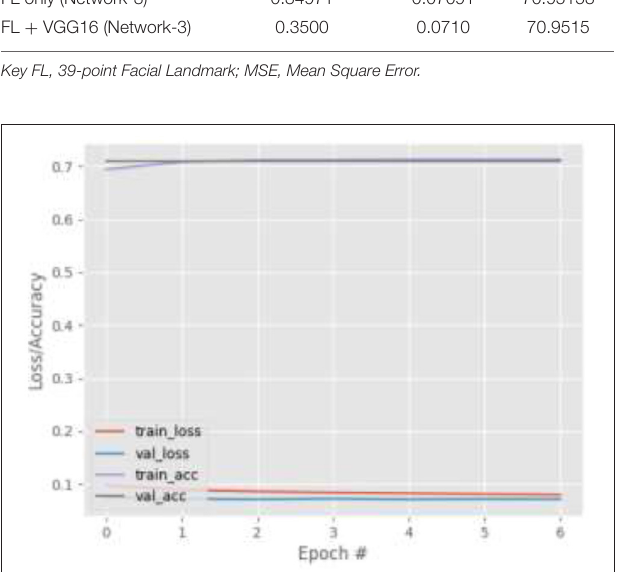
FIGURE 9 | Results for Face + FL on TabletGaze dataset.